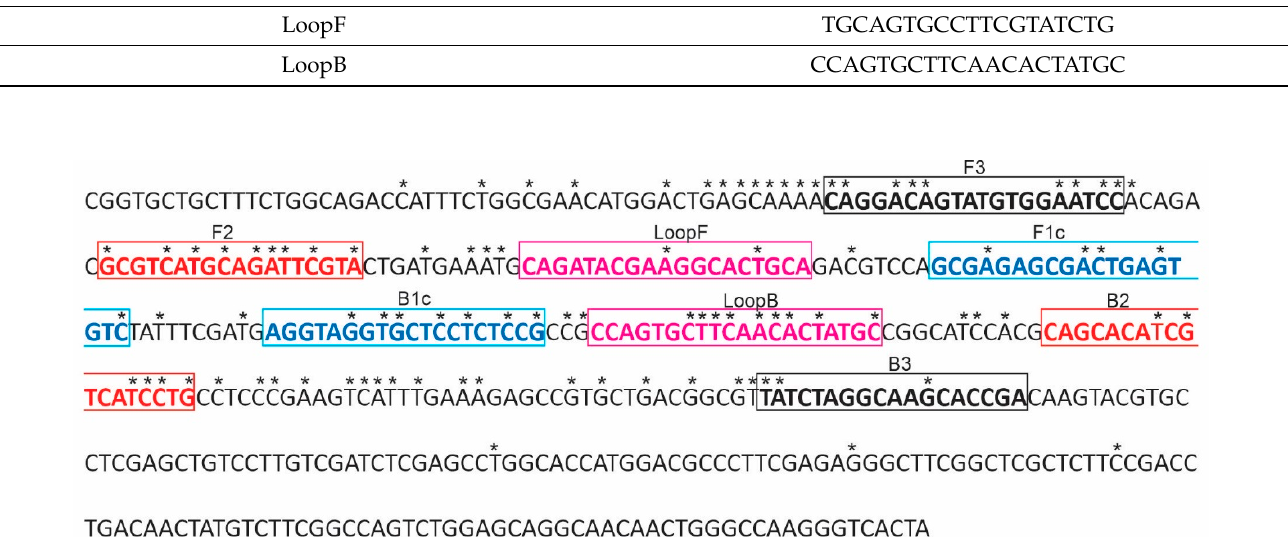
Figure 1. Position of LAMP primers based on consensus sequence of D. septosporum β -tubulin 2 gene sequences retrieved from GenBank (AY808205–AY808230). Primer FIP is a combination of F1c and F2, while primer BIP is a combination of B1c and B2. Differences from D. pini are noted by * symbol.